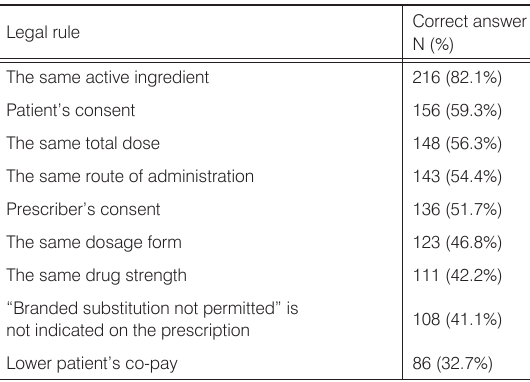
Table 3. Understanding of the legislation for GS (N=263)